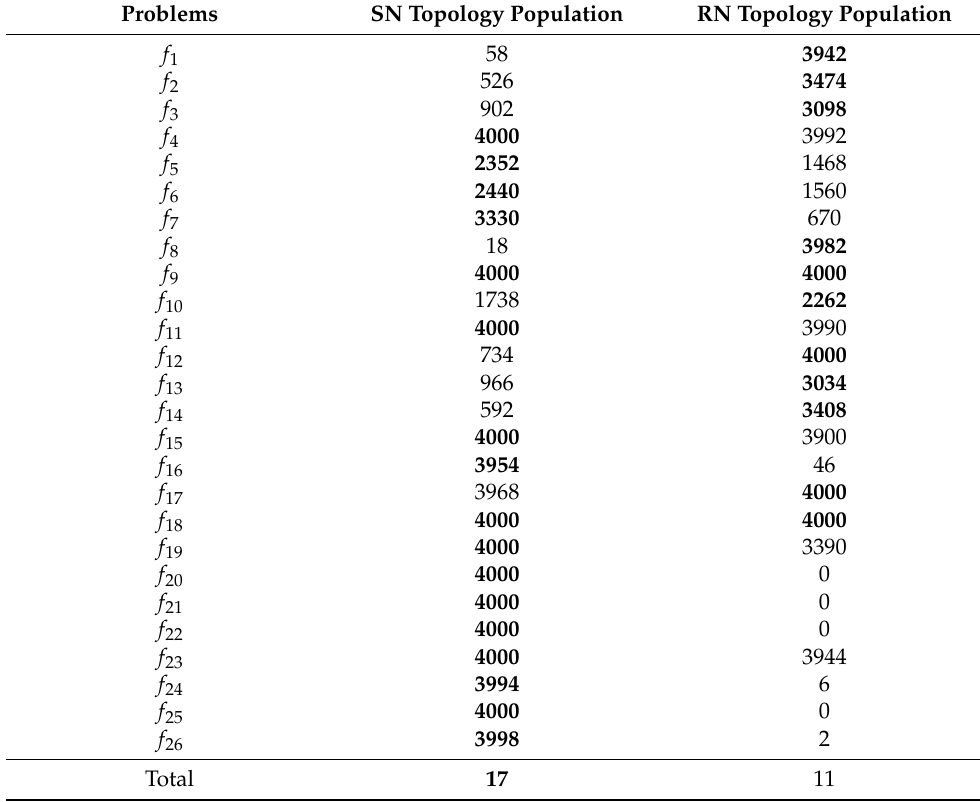
Table 9. The statistical times of two populations achieving the optimal